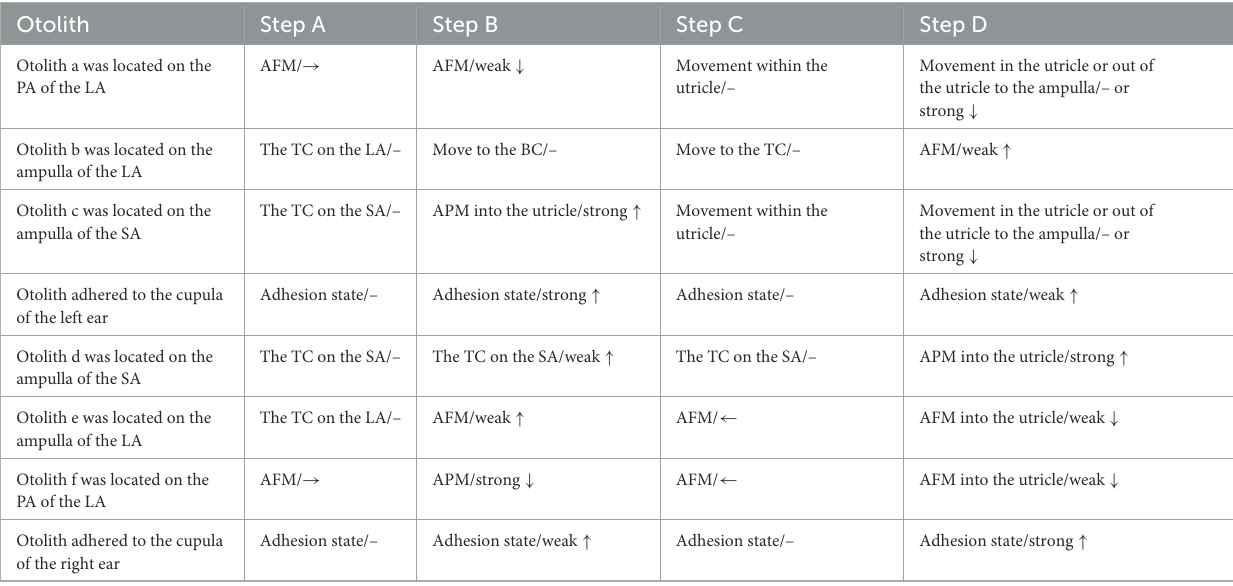
TABLE 1 Otolith motion and nystagmus speculation in the supine roll test. Otolith Step A Step B Step C Step D Otolith a was located on the AFM/ → AFM/weak ↓ Movement within the Movement in the utricle or out of PA of the LA utricle/– the utricle to the ampulla/– or strong ↓ Move to the BC/– Move to the TC/– AFM/weak ↑